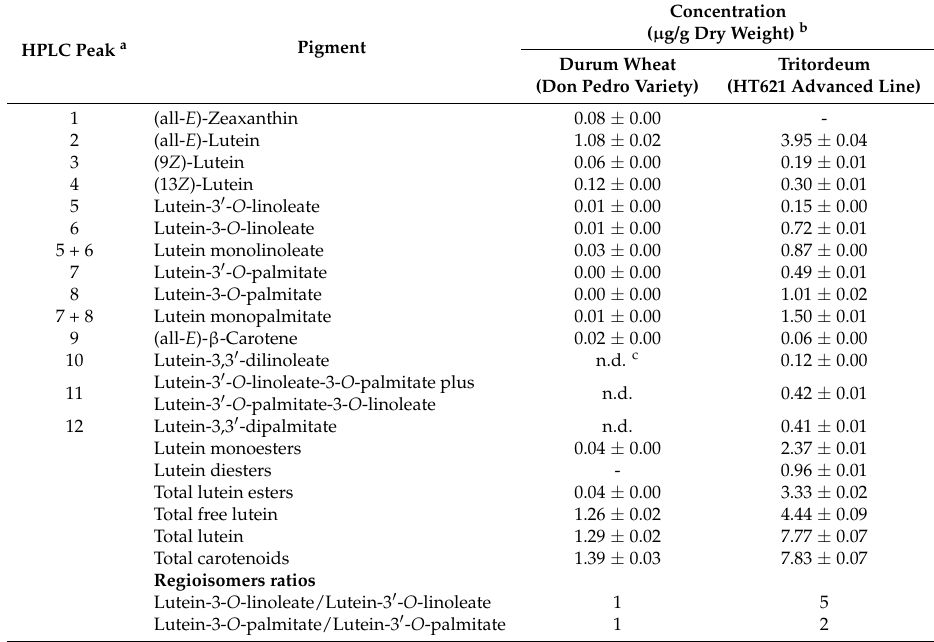
Table 2. Initial carotenoid composition in Triticum turgidum cv. durum (Don Pedro variety) and Tritordeum (HT621 line) whole-grain flours subjected to long-term storage (12 months) under controlled